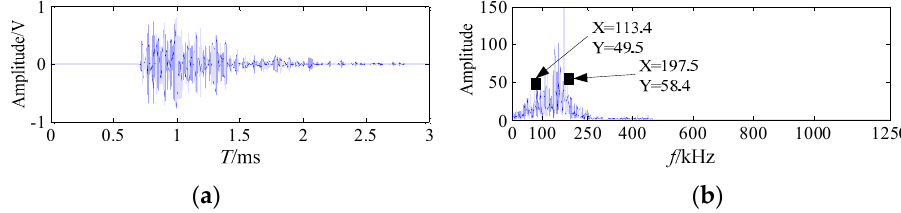
Figure 15. The waveform and spectrum of the welding crack AE signal after noise reduction ( a ) the waveform; ( b ) the frequency spectrum